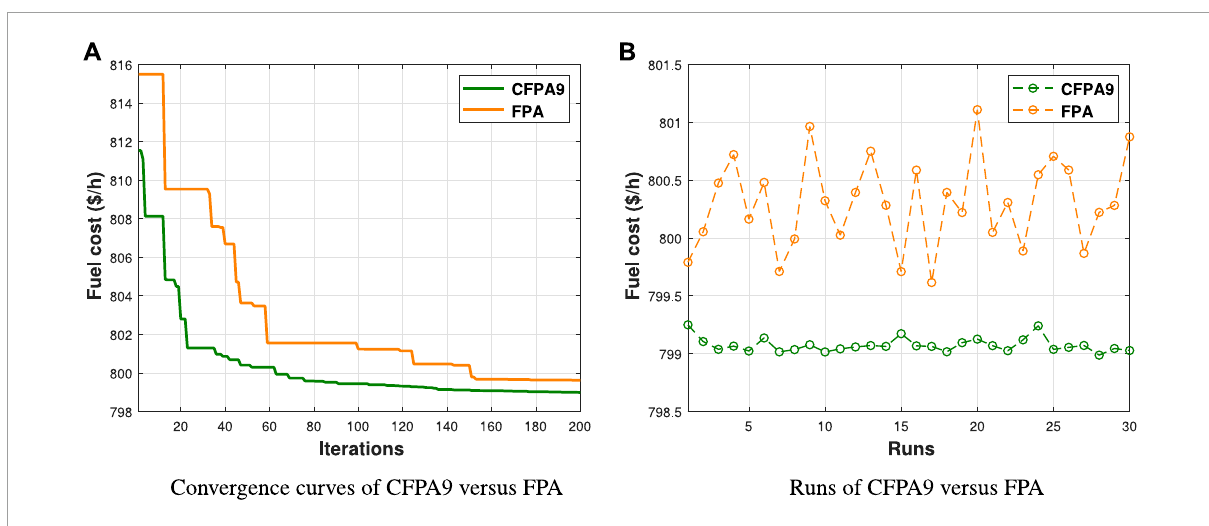
FIGURE 8 Fuel cost convergence and run for FPA vs. CFPA9 for case 1. (A) Convergence curves of CFPA9 versus FPA and (B) runs of CFPA9 versus